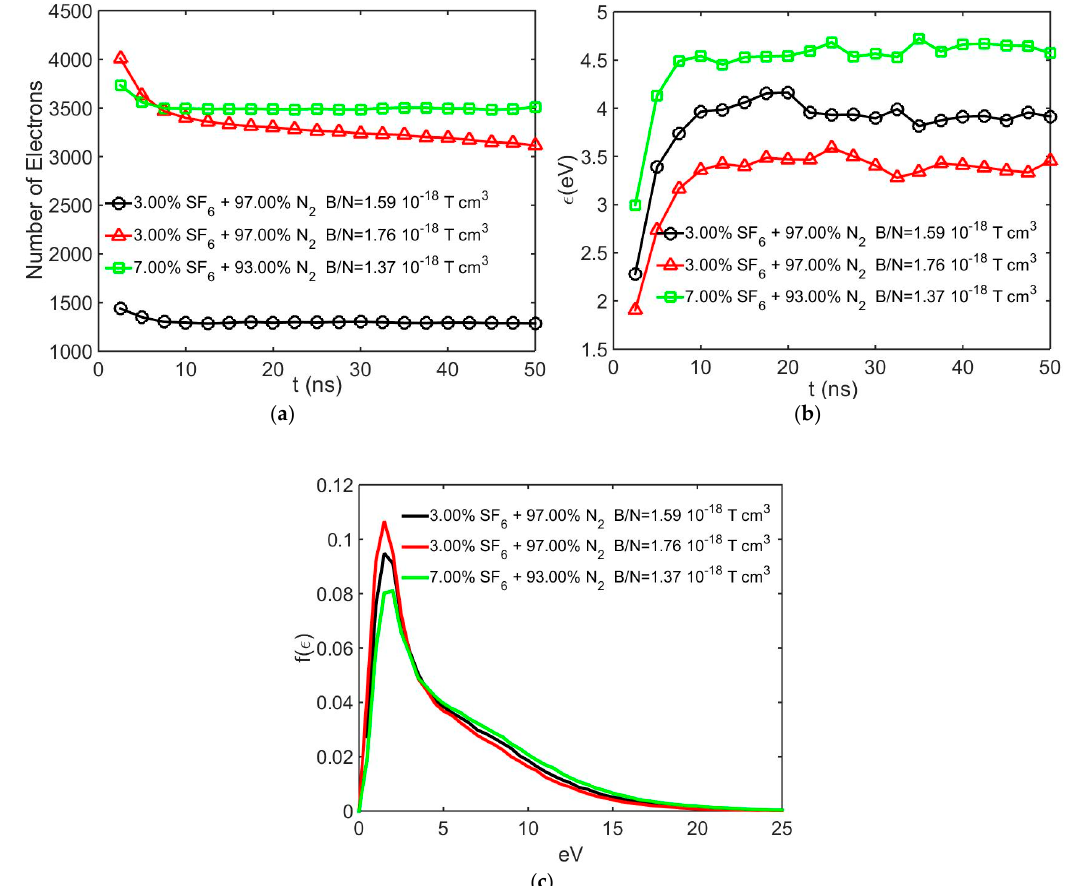
Figure 11. The 3% SF 6 + 97% N 2 and 7% SF 6 + 93% N 2 mixtures at 400 Td with different magnitudes of crossed magnetic field: ( a ) number of electrons; ( b ) electron mean energies; ( c ) electron energy distribution functions (Corresponding magnetic field strength; Black line: H = 4.20 × 10 4 A/m, Red line: H = 4.65 × 10 4 A/m, Green line: H = 3.62 × 10 4 A/m).